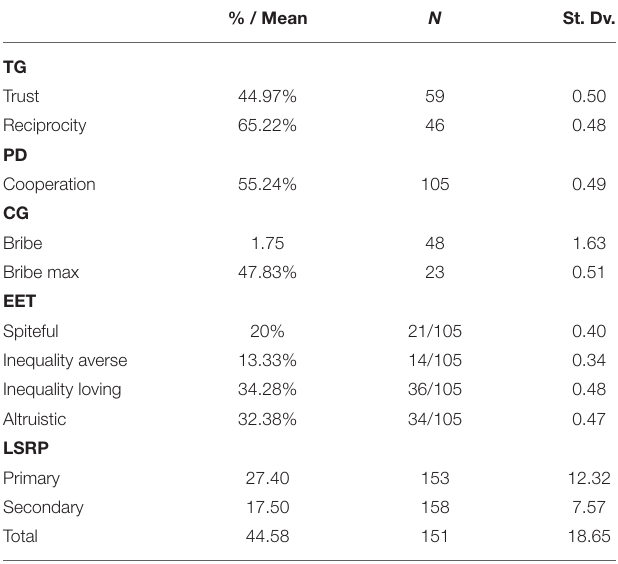
TABLE 3 | Summary